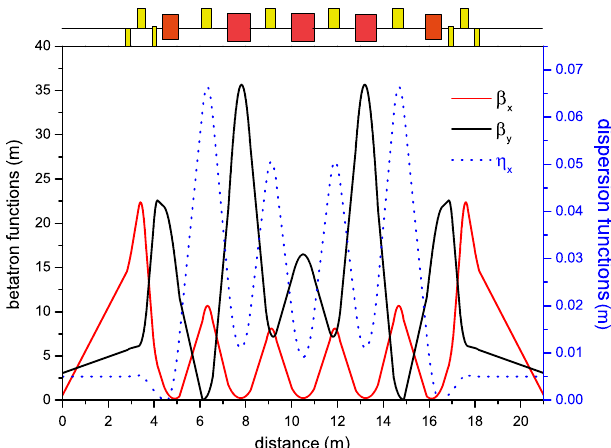
FIG. 2. The betatron function and dispersion function of the minimum emittance lattice. The emittance value is 57 pm